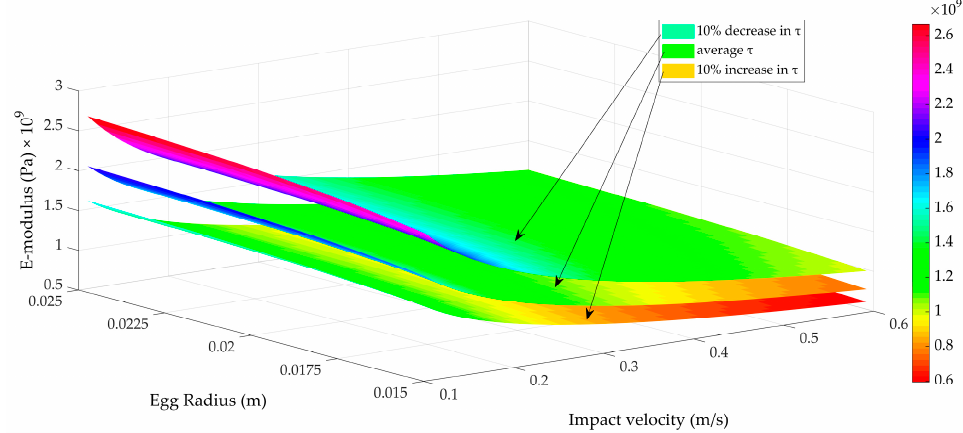
Figure 7. Sensitivity analysis showing the influence of the impact velocity (x-axis), egg radius (y-axis) and the contact duration (given as three separate surfaces) on Young’s (or E) modulus (z-axis).